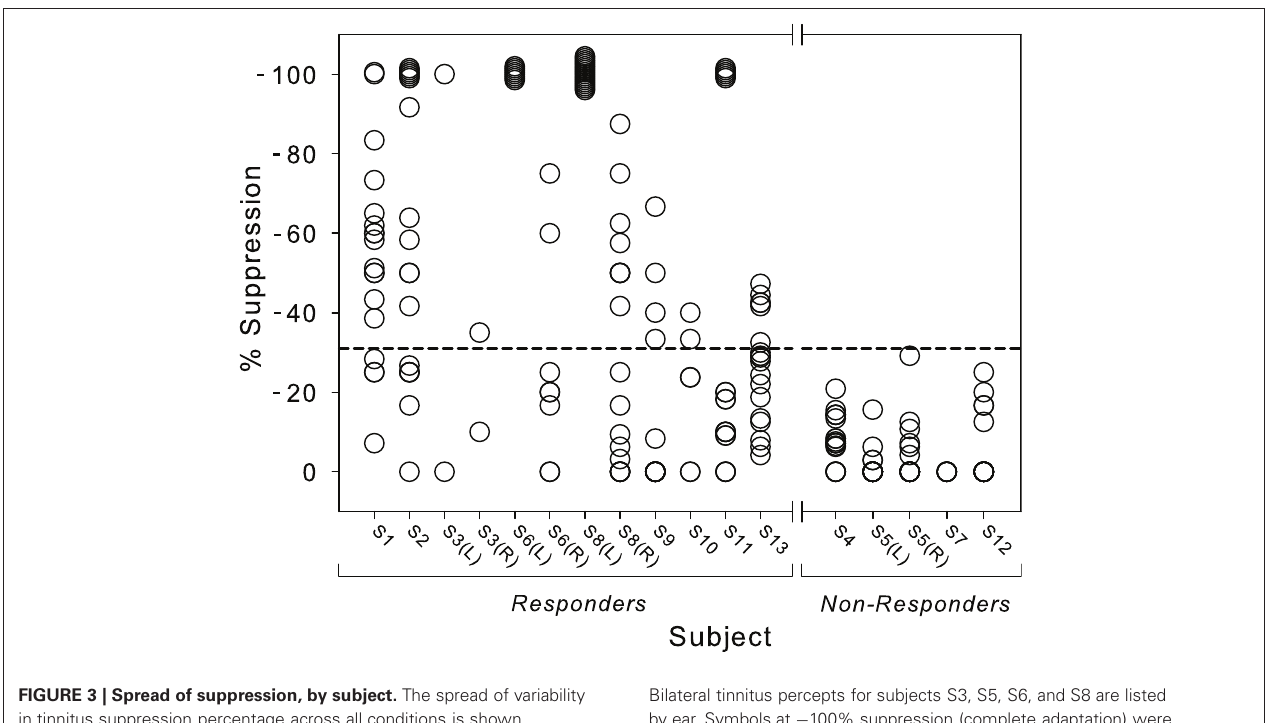
FIGURE 3 | Spread of suppression, by subject. The spread of variability in tinnitus suppression percentage across all conditions is shown for each subject. Subjects are listed across the x -axis and grouped as Responders (left) or Non-Responders (right). Each open circle represents the maximal tinnitus suppression for a given condition.